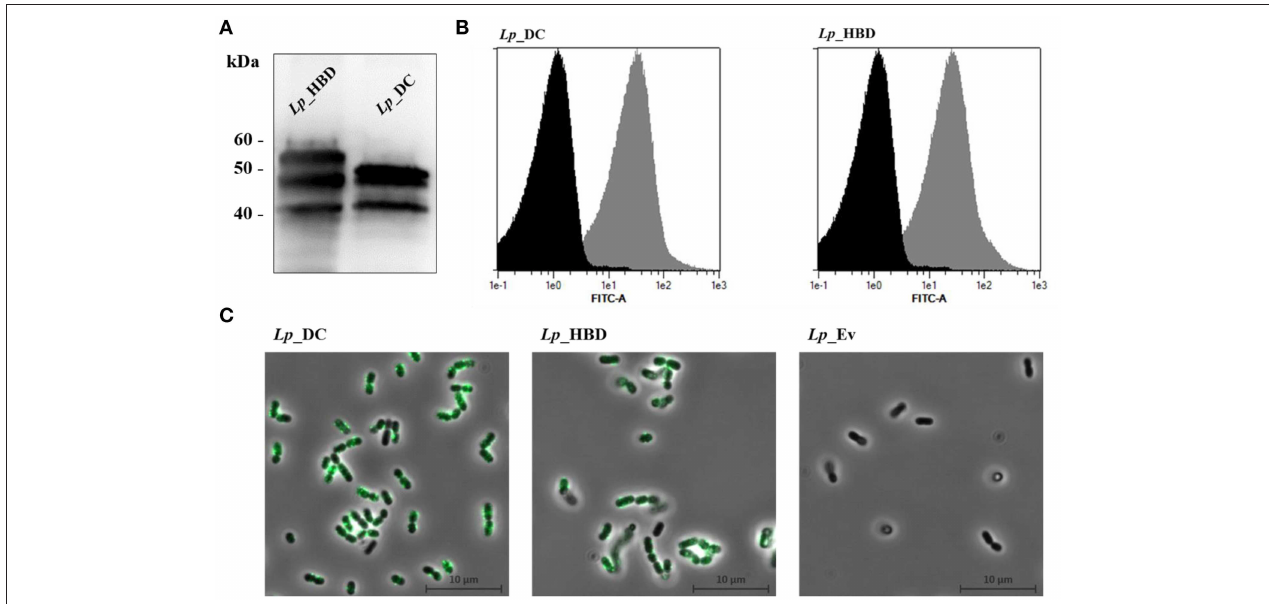
FIGURE 3 | Production (A) and surface localization (B,C) of the recombinant AgE6 antigen. Production of the anchor-fused AgE6 in Lp _DC and Lp _HBD constructs was analyzed by Western blotting and is shown in (A) . The positions of size marker proteins are indicated and predicted sizes of the detected proteins ( Figure 1 ) are 48.4 and 54.1 kDa for Lp _DC and Lp _HBD constructs, respectively. The presence of AgE6 on the bacterial surface was detected using immunofluorescent methods: flow cytometry and fluorescent microscopy. Lp _Ev was used as a negative control strain. Panel B shows flow cytometry analysis for Lp _DC and Lp _HBD (gray histograms) and Lp _Ev (black histograms). Panel C shows indirect immunofluorescence microscopy of the indicated constructs. The data presented are from a representative experiment. Each experiment was performed three times, giving similar